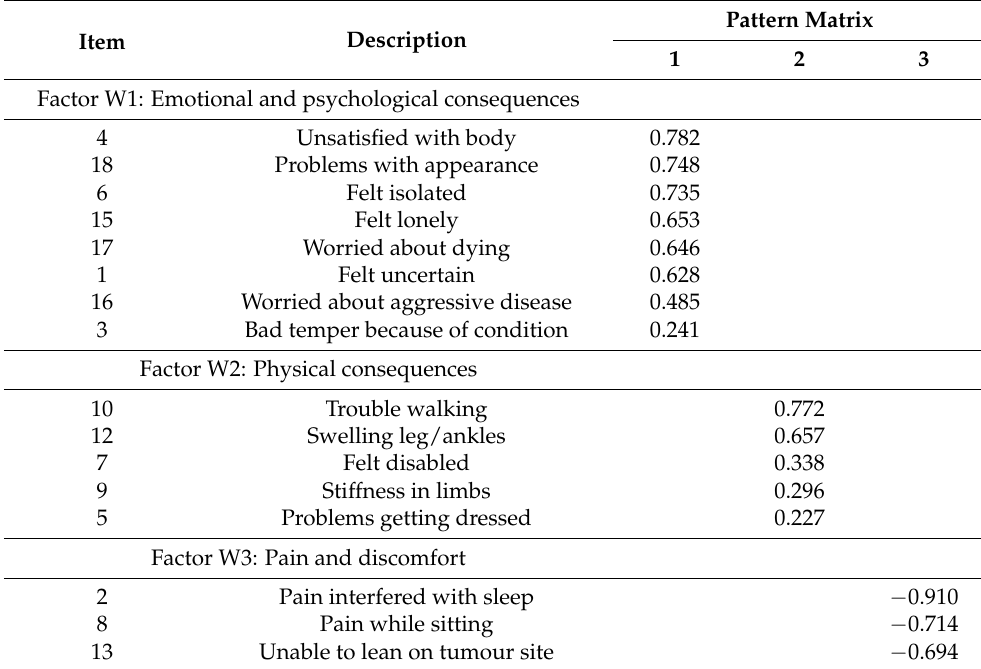
Table 3. Rotated component matrix (factor loadings pattern matrix) items with time frame during the past week.